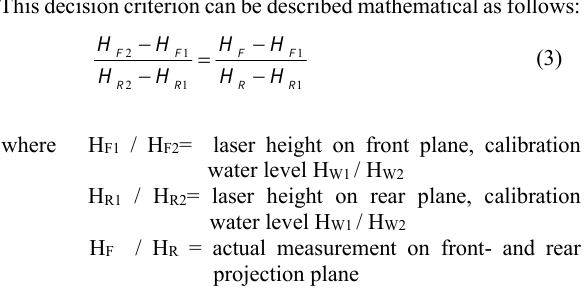
Figure 8: Detection of horizontal water surface element based on calibration on still water